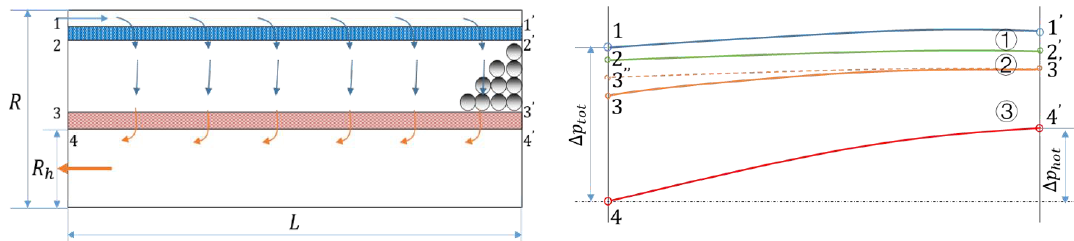
Figure 6. Schematic diagram of the pressure profile along the axial direction at several radial positions under “U” flow pattern conditions. 1-1’, outer cold frit interface; 2-2’, inner cold frit interface; 3-3’, outer hot frit interface; 4-4’, inner hot frit interface.